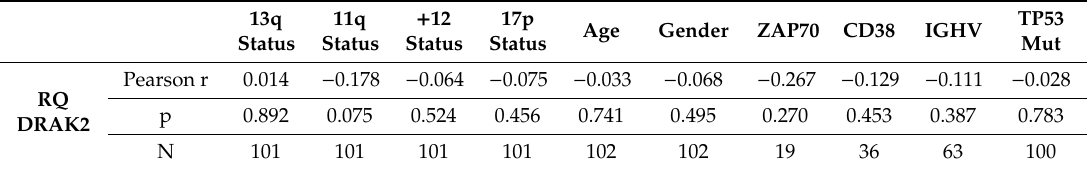
Table 3. Correlation analysis between relative expression of DRAK2 and common clinical and molecular biomarker in CLL.